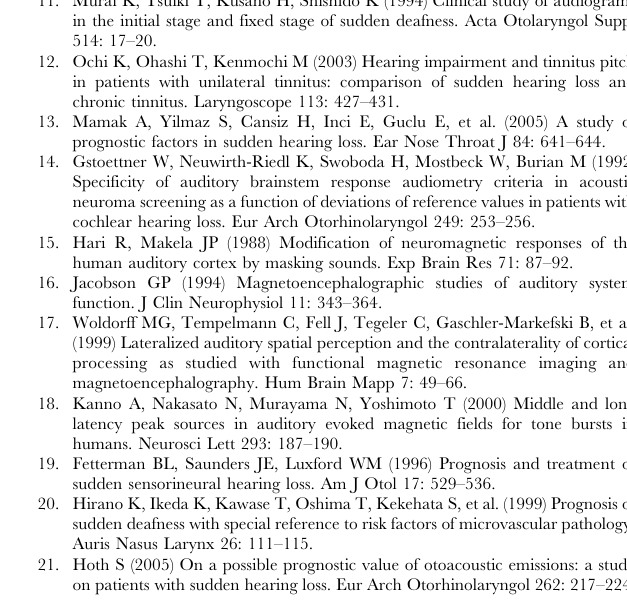
Table S3 Amplitude and latency of peak dipole moment for